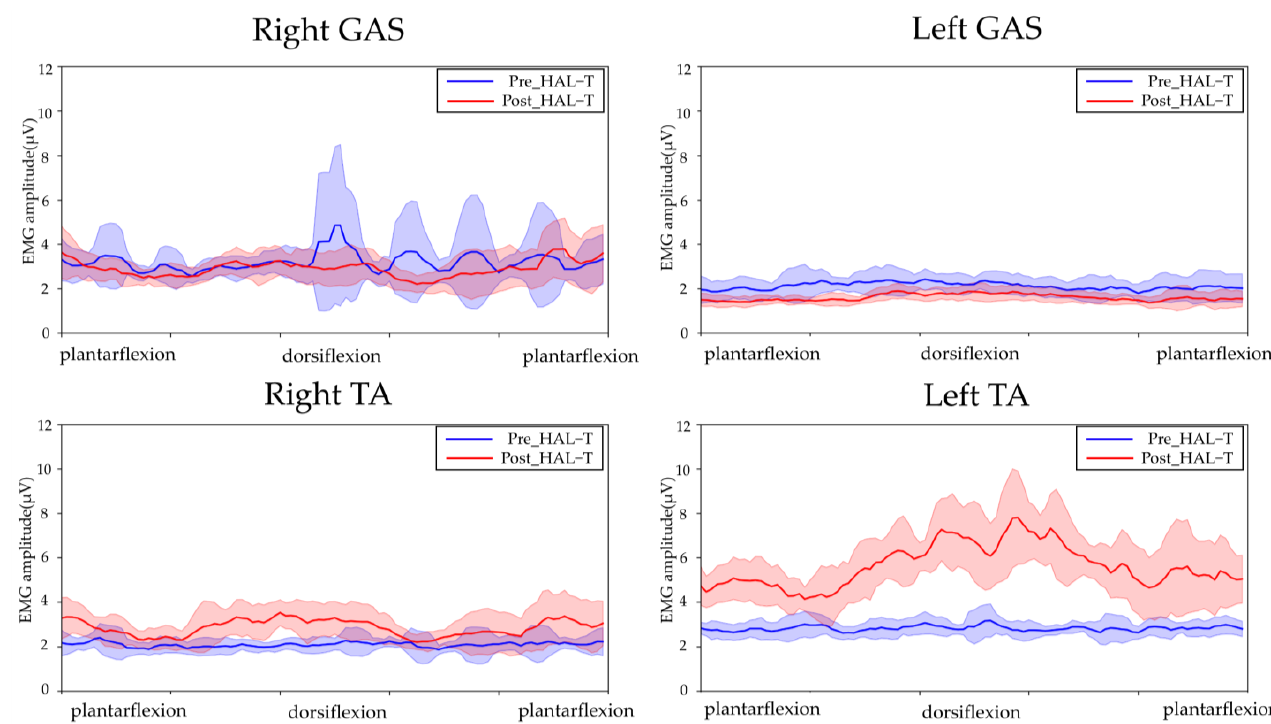
Figure 5. EMGs of the left and right tibialis anterior (TA) and gastrocnemius (GAS) muscles during ankle joint plantar dorsiflexion movement in the end-sitting position. The blue line shows EMG before HAL-T and the red line shows after HAL-T. The raw EMGs were rectified and smoothed (RMS algorithm with a smoothing window width of 100 ms), and the 10 ankle plantar dorsiflexion movements were averaged. The results are presented in the graph as means ± standard deviations.